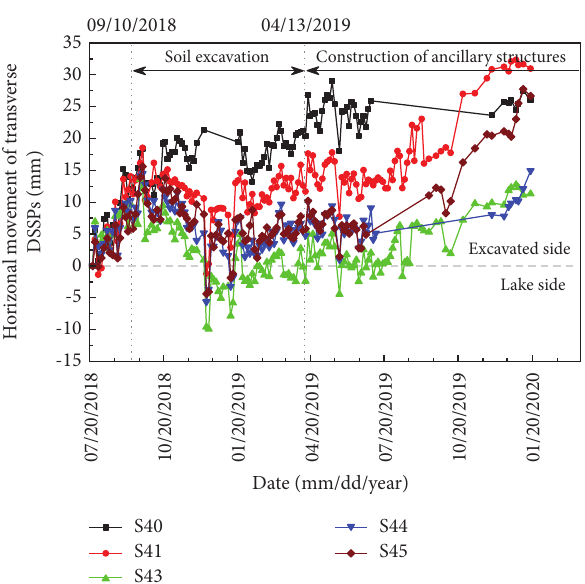
Figure 11: Development of the horizontal movements of the transverse